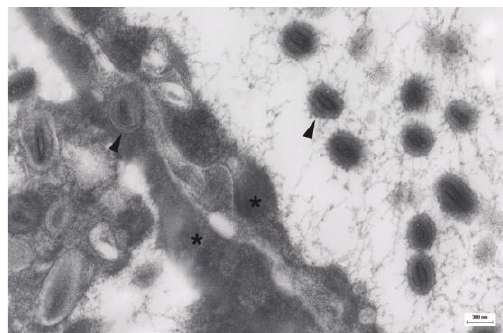
Figure 7: Lip. Two keratinocytes with adjacent degenerate cell membranes ( ∗ ) contain numerous 200–300 nm brick-shaped viri- ons (arrowheads) free within the cytoplasm. Virions show typi- cal parapoxvirus characteristics of an inner core surrounded by an intermediate coat further bounded by an envelope. Transmission electron microscope, lead citrate and uranyl acetate. Bar = 300